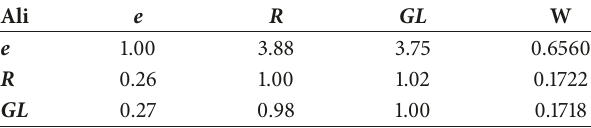
Table 7: Comparison for sight distance node.